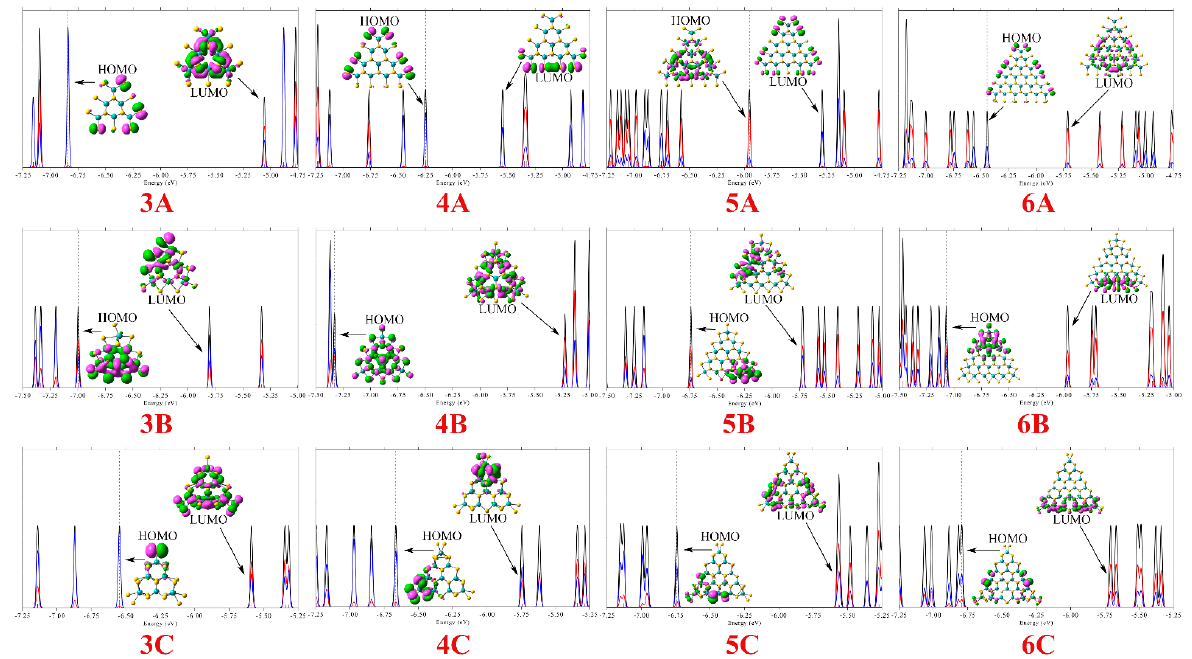
Figure 2. The density-of-states (DOS) map, as well as HOMO and LUMO distributions of A , B , and C . The discrete represents the MOs, the black, blue, and red curves represent the total DOS, partial DOS of S 3 p , and partial DOS of Mo 4 d , respectively.